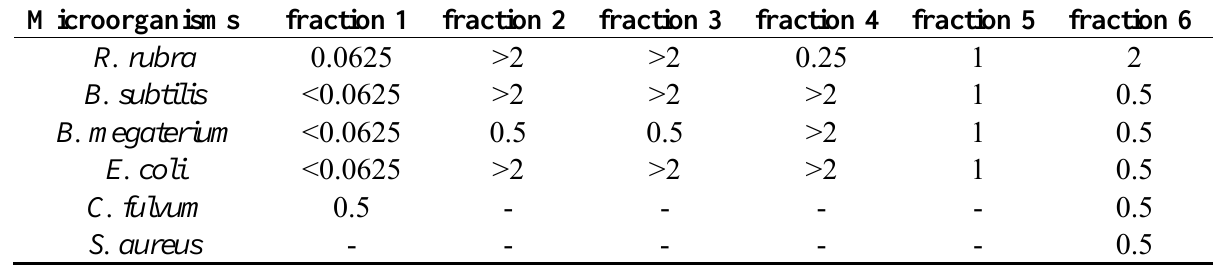
Table 1. Antimicrobial activity of fractions 1-6 (MIC values,